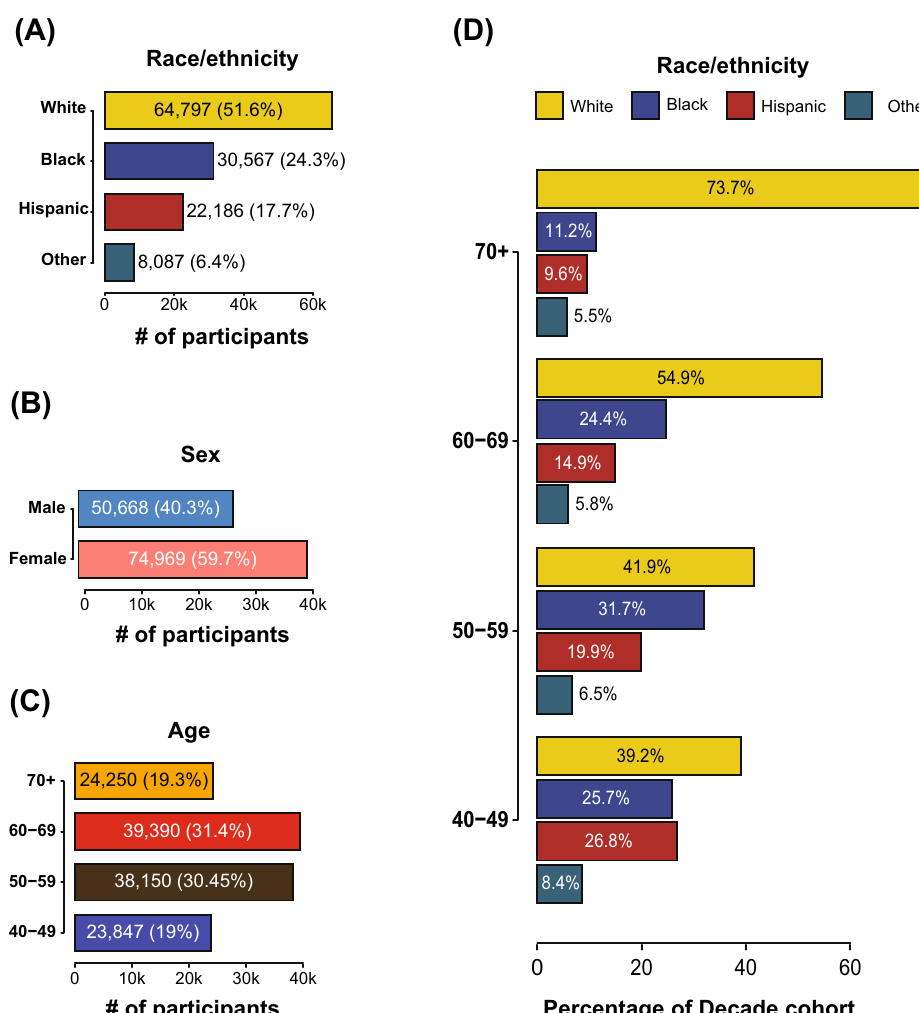
Figure 2. Demographic data for the AoU participant cohort. ( A ) Distribution of self-identified race/ethnicity (SIRE) labels in the study cohort. SIRE designations that were below the reportable minimum were merged with missing or generalized data. ( B ) Distributions of the sex at birth for participants who provided this information. ( C ) Age distribution of the participants included in this study cohort. Only participants above the age of 40 were selected for the study. Participants for whom this information was unavailable were not included in the study cohort. ( D ) Cohort proportions stratified by SIRE and age